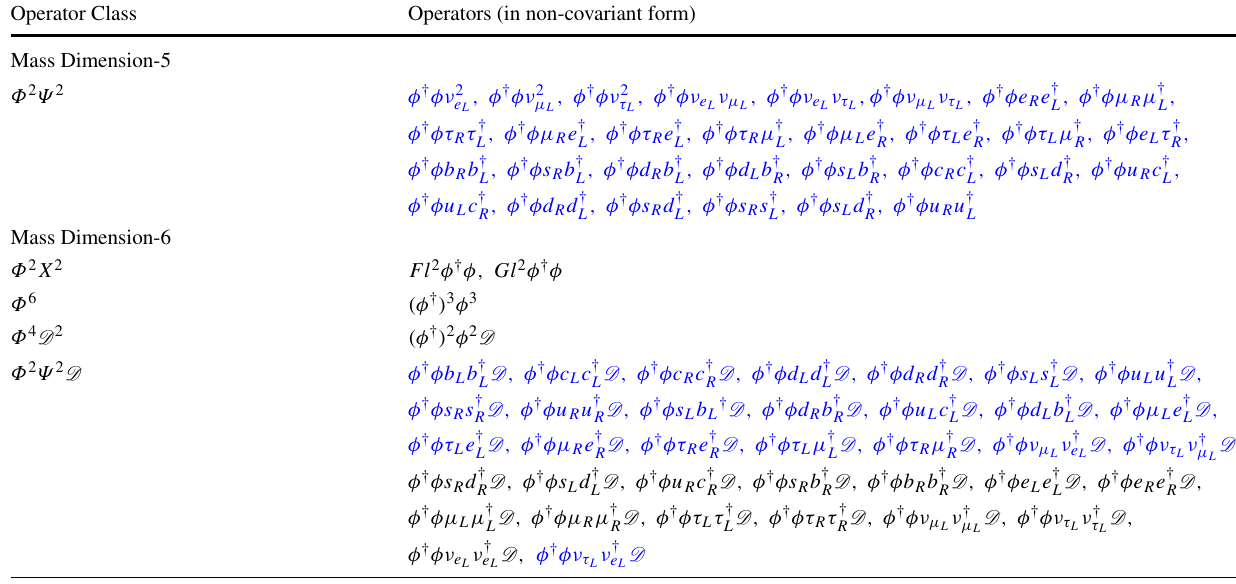
Table 44 Model 1( φ ): Operators of mass dimensions-5 and -6 excluding pure SM operators